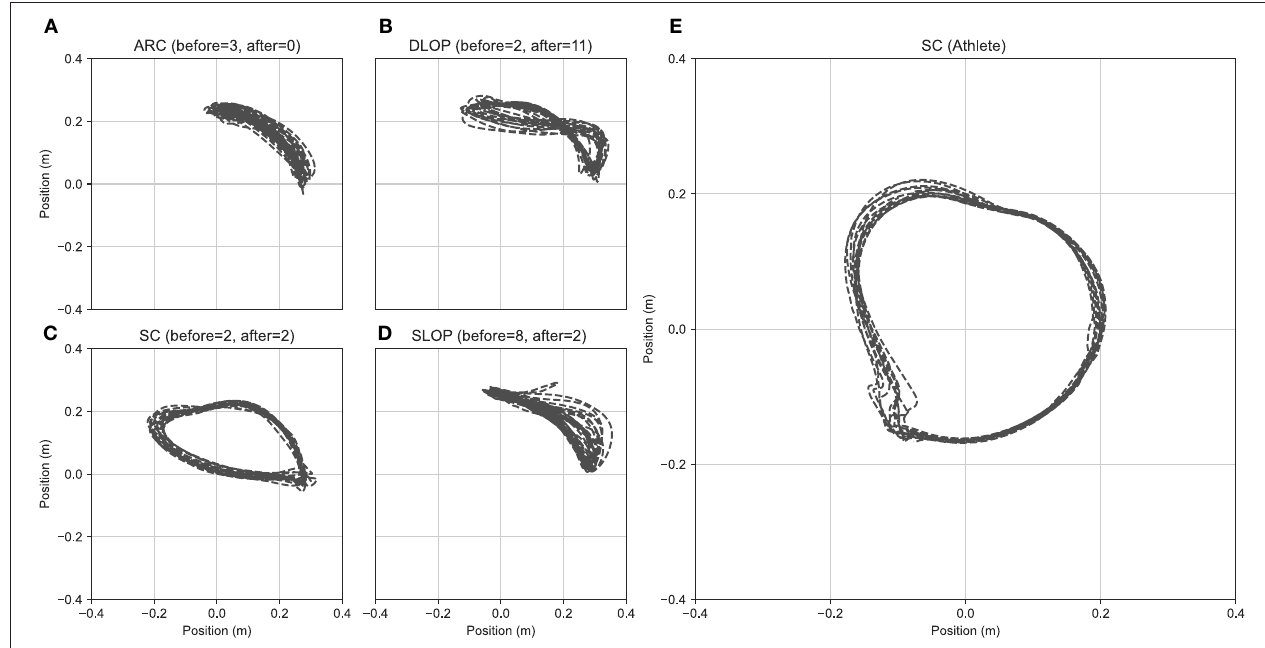
FIGURE 4 | Typical kinematics examples of the last fifteen seconds of the M2 virtual marker position displayed by different participants (each subplot shows one): (A) arcing, (B) double looping over, (C) semicircular, (D) single looping over propulsion, (E) semicircular, athlete. All data are from the last block of the last session with the exception of panel (A)